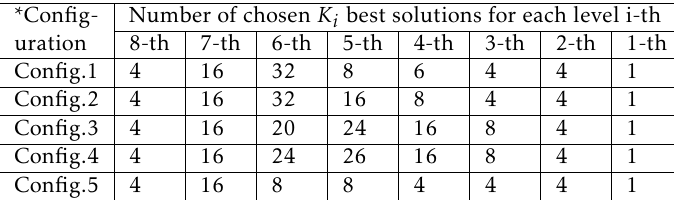
Table 1. Configurations of EHSD algorithm